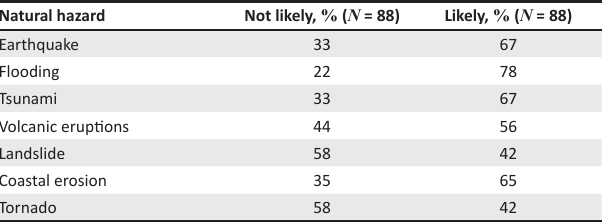
TABLE 1: Community risk awareness and perception: Descriptive summary results for hazards likely to affect Auckland. Natural